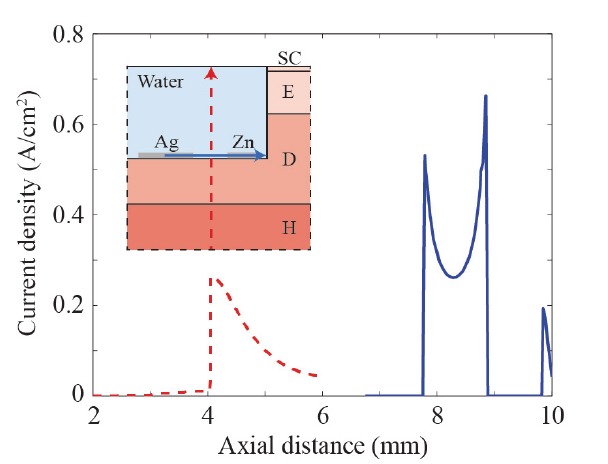
Fig.6: The electric current density in the wound area with a Procellera ® wound dressing applied with Zn closest to the wound edge. The current density approaches 1 A/cm 2 in the region between the dots (solid blue) and falls off quickly in the perpendicular direction (dashed red). Especially when going down into the dermis, which has a low conductivity compared to the wound fluid.